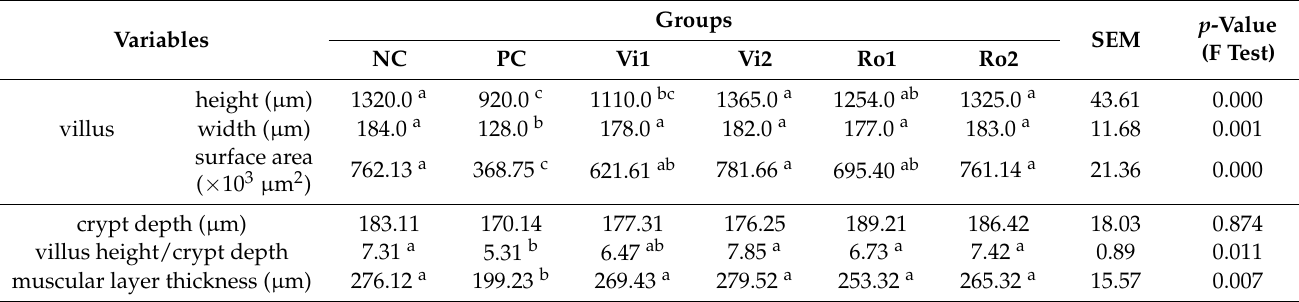
Duodenal histomorphology affected by dietary vinegar and rocket salad of stressed broiler chickens ( n = 16/treatment).